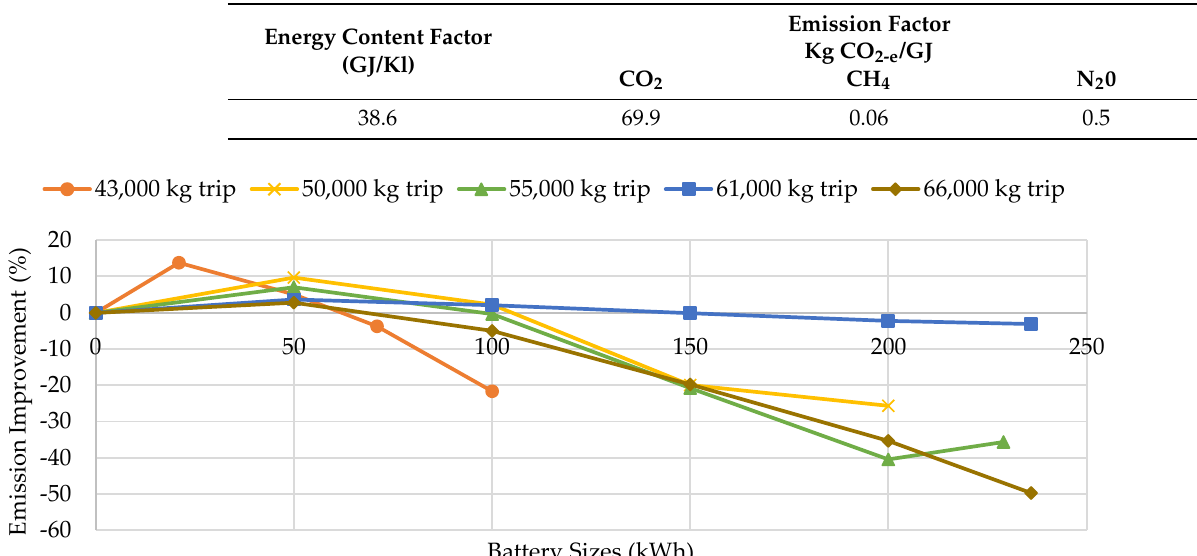
Table 12. Euro 5 fuel emission factors for diesel oil used in general transport [23].